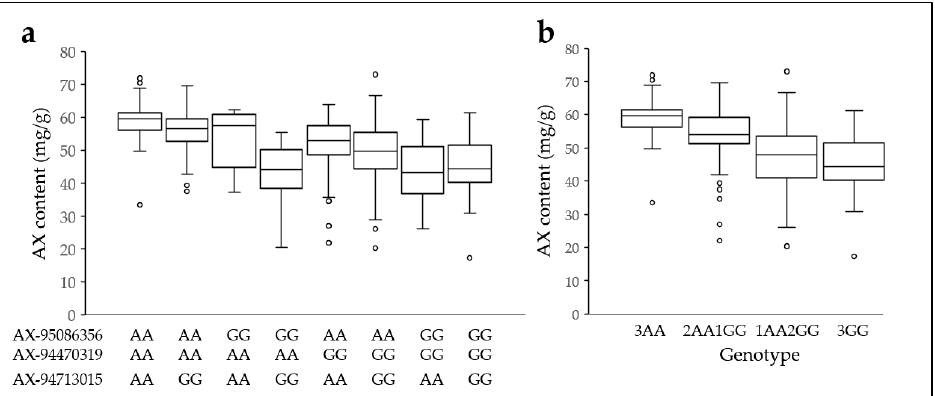
Figure 7. Arabinoxylan distribution of three allele combinations. Arabinoxylan content in eight com- binations of three SNPs ( a ) and three adenine, two adenine and one guanine, one adenine and two guanine, and three guanine combinations ( b ). AX, arabinoxylan; A, adenine; G,